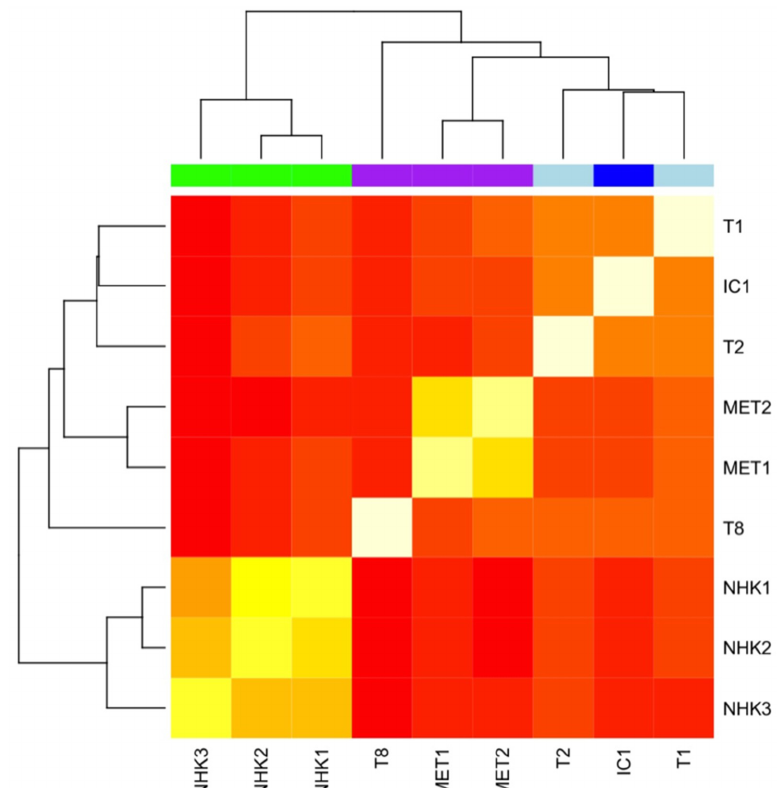
Figure 5. Heatmap of Pearson’s correlation of genome-wide methylation profiling of six cSCC cell lines and three normal human keratinocytes (NHK). NHK (green) cluster together separately from cSCC, poorly-di ff erentiated cSCC (purple) form a cluster with the two isogenic cell lines—MET1 and MET2—forming a tight subcluster. Two well-di ff erentiated cell lines (T1 and T2, light blue) formed a cluster with a moderately-di ff erentiated cell line, IC1 (dark